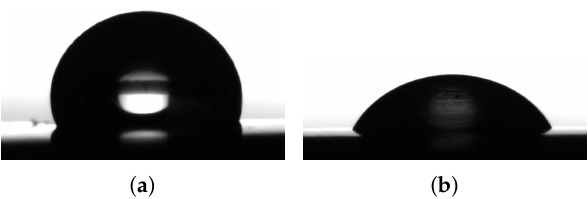
Figure 2. ( a ) contact angle measurement from glycerol drop on non-polar surface; ( b ) oil drop on non-polar surface.